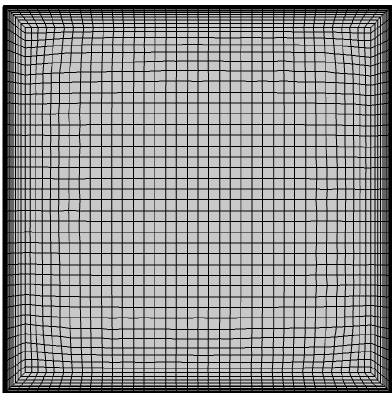
Figure 2. Computational grid structure of the model. Table 1. Comparison of average Nusselt numbers for different Rayleigh numbers.